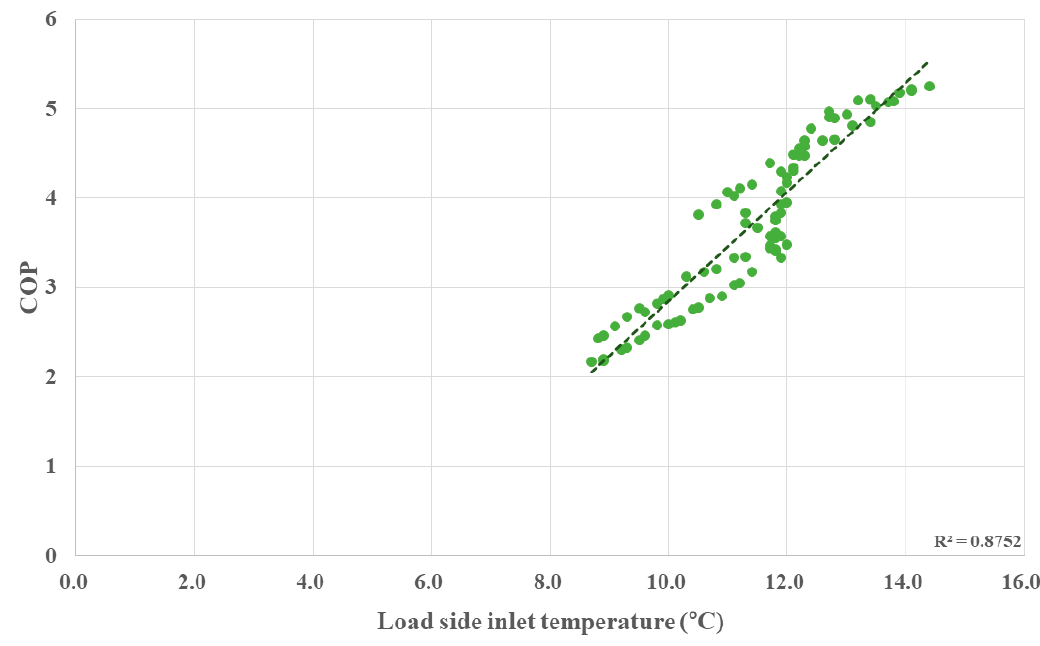
Figure 9. Performance according to load-side inlet temperature during cooling operating.